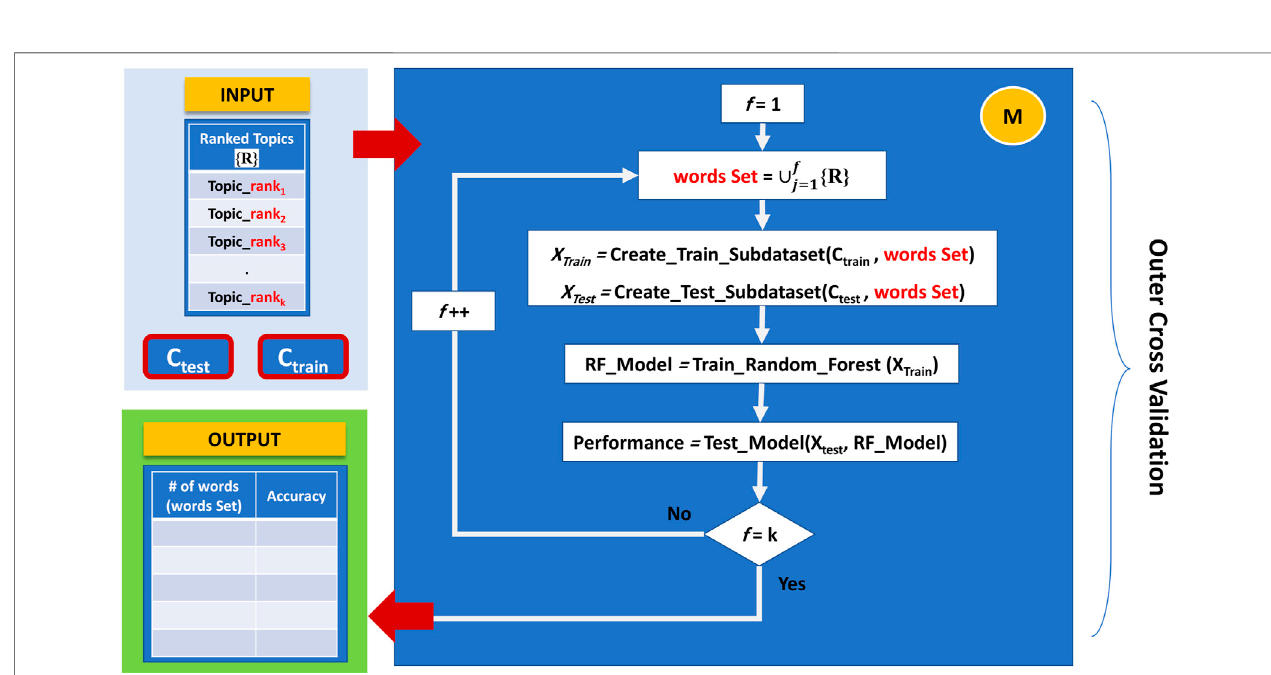
FIGURE 5 | Performing internal cross-validation on the topic-based sub-dataset to assign a score to the associated topic.